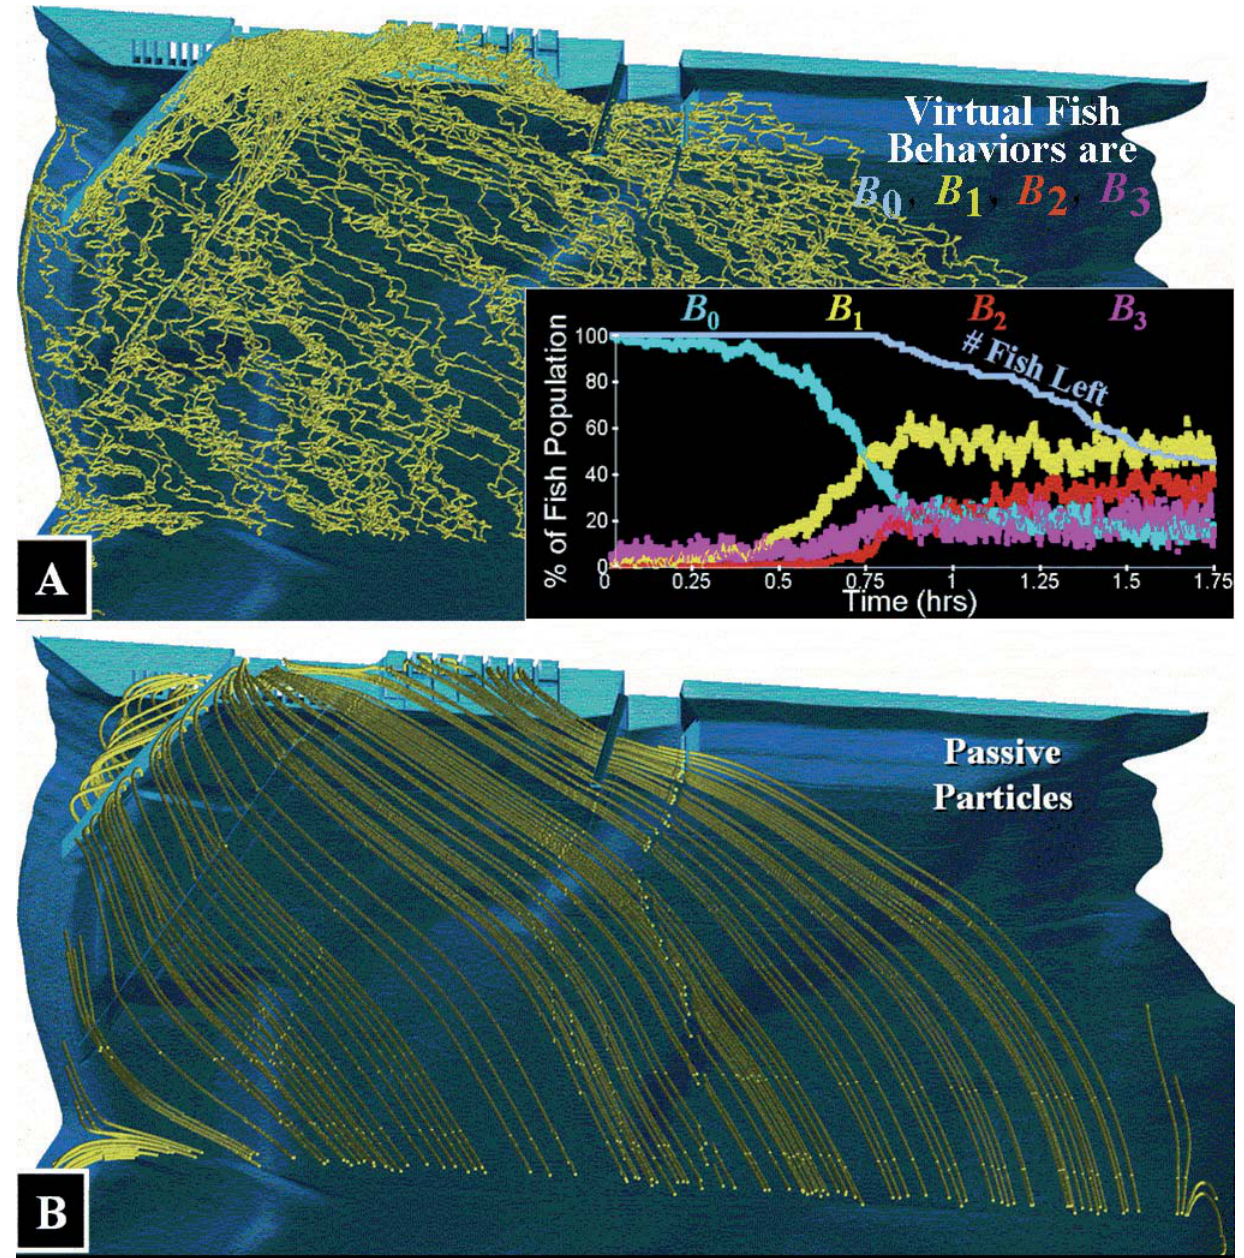
Fig. 2. Comparison of movement of 100 NFS virtual emigrants [A] and 100 passive particles [B] released 700 m upstream of Lower Granite Dam. Virtual emigrant and particle tracks are yellow. Note the pattern of behavior changes as the virtual fish approach the dam (inset plot in [A]). Upstream of the dam, the default behavior B more dominant as the hydrodynamic environment becomes more complex near the dam (inset to